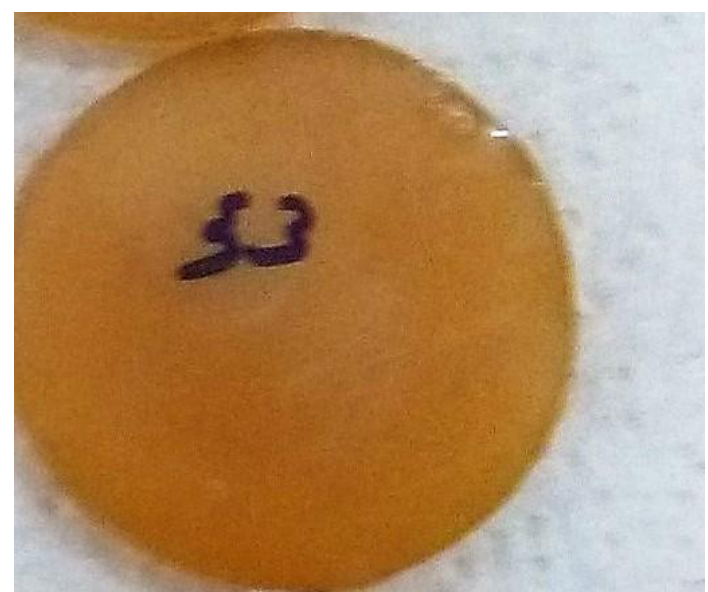
Fig. 1: Sample of thermal conductivity for blend+sand 53 µm.